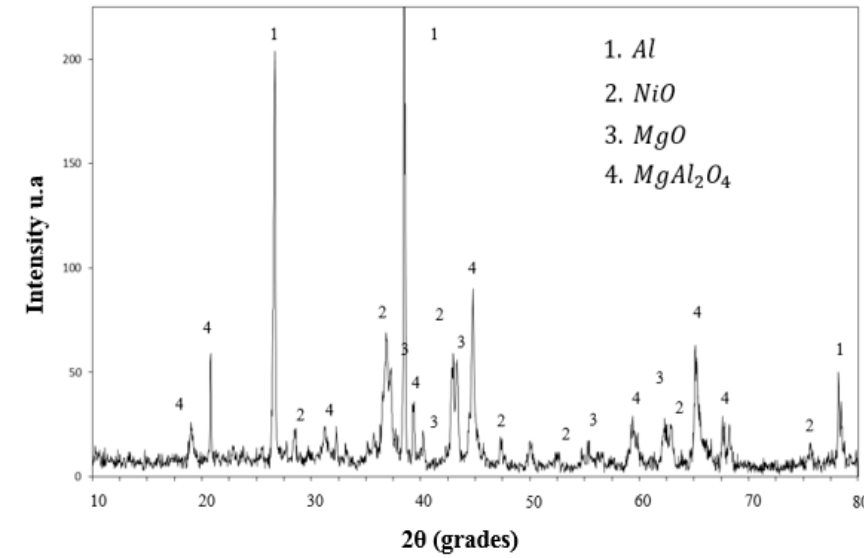
Figure 10. XRD pattern of the slag samples for an alloy where the initial magnesium was 3 wt-% at a stirring speed of 300 rpm and a temperature of 1123 K.